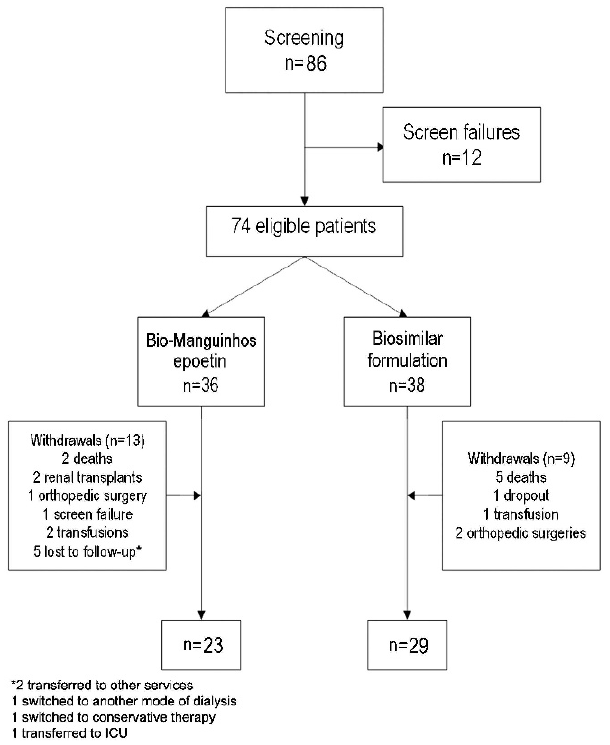
Figure 1 - Flow chart of patient enrollment and